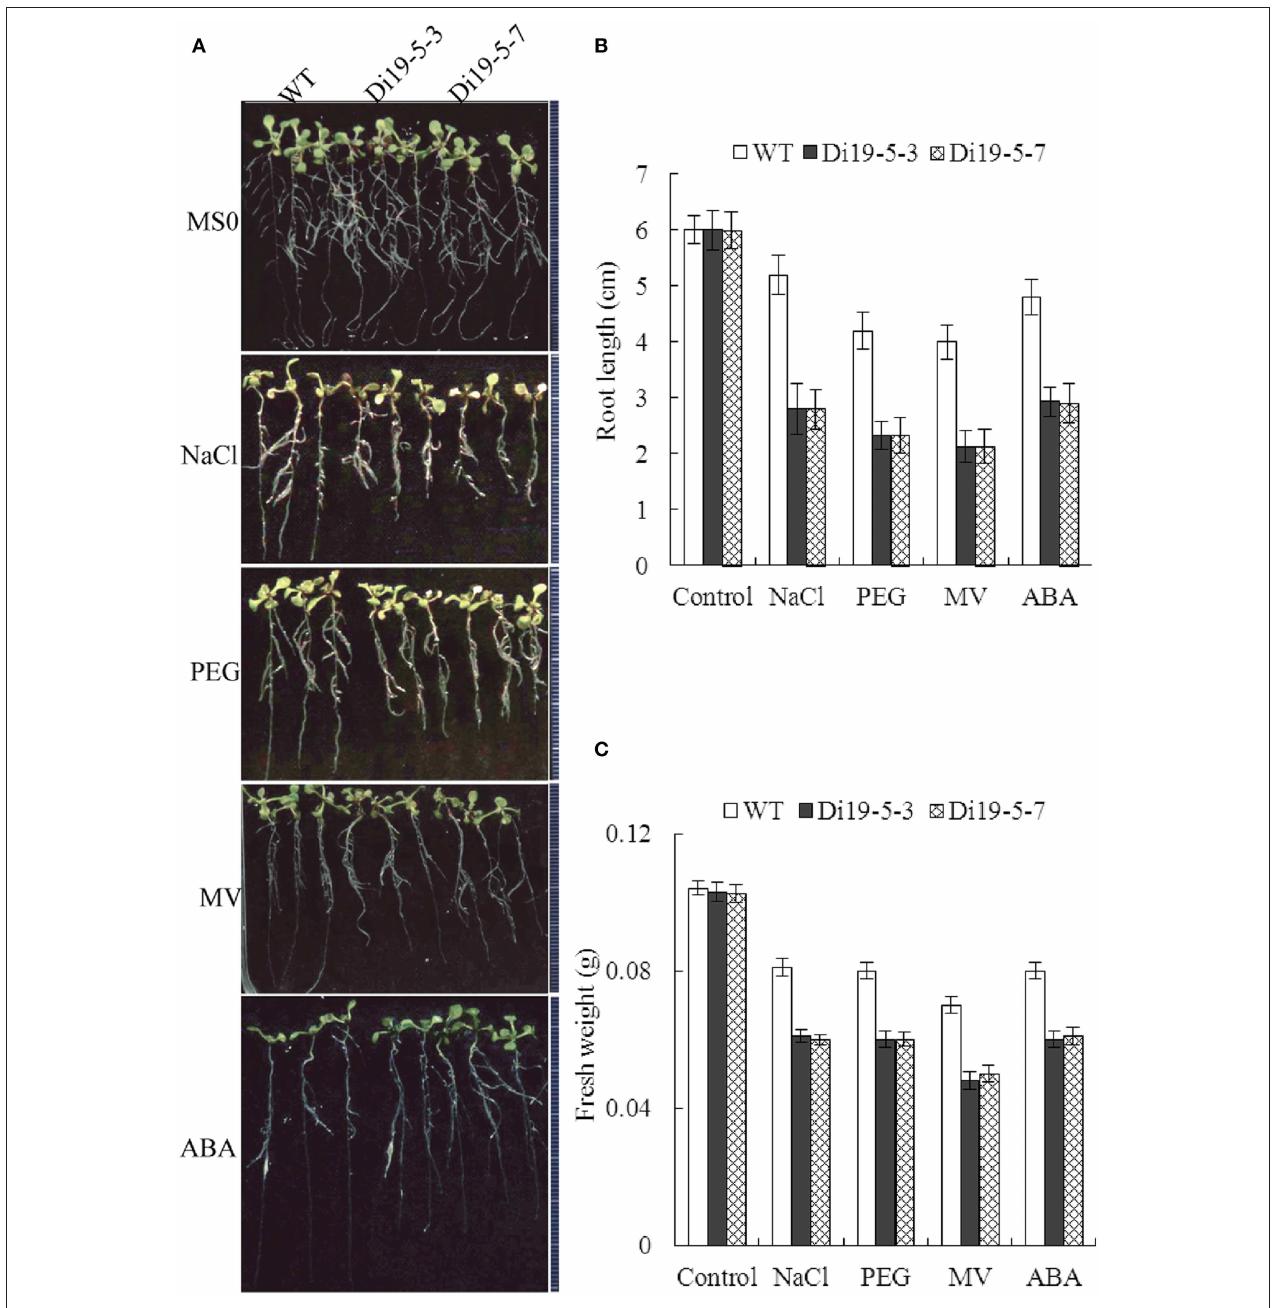
FIGURE 10 | Effect of salt, drought, oxidative, and ABA stresses on root length of GmDi19-5 transgenic and WT seedlings. (A) Root length of seedlings were transferred to a medium with or without NaCl, PEG, MV,